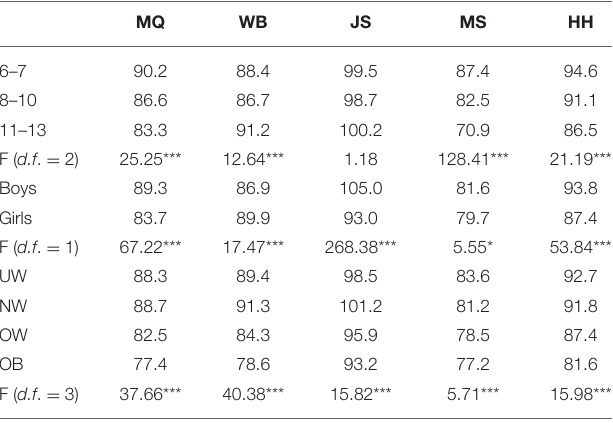
TABLE 2 | Total MQ and subtest scores of the KTK by age groups, gender classes, and weight status categories, with F-values and significance levels across the single